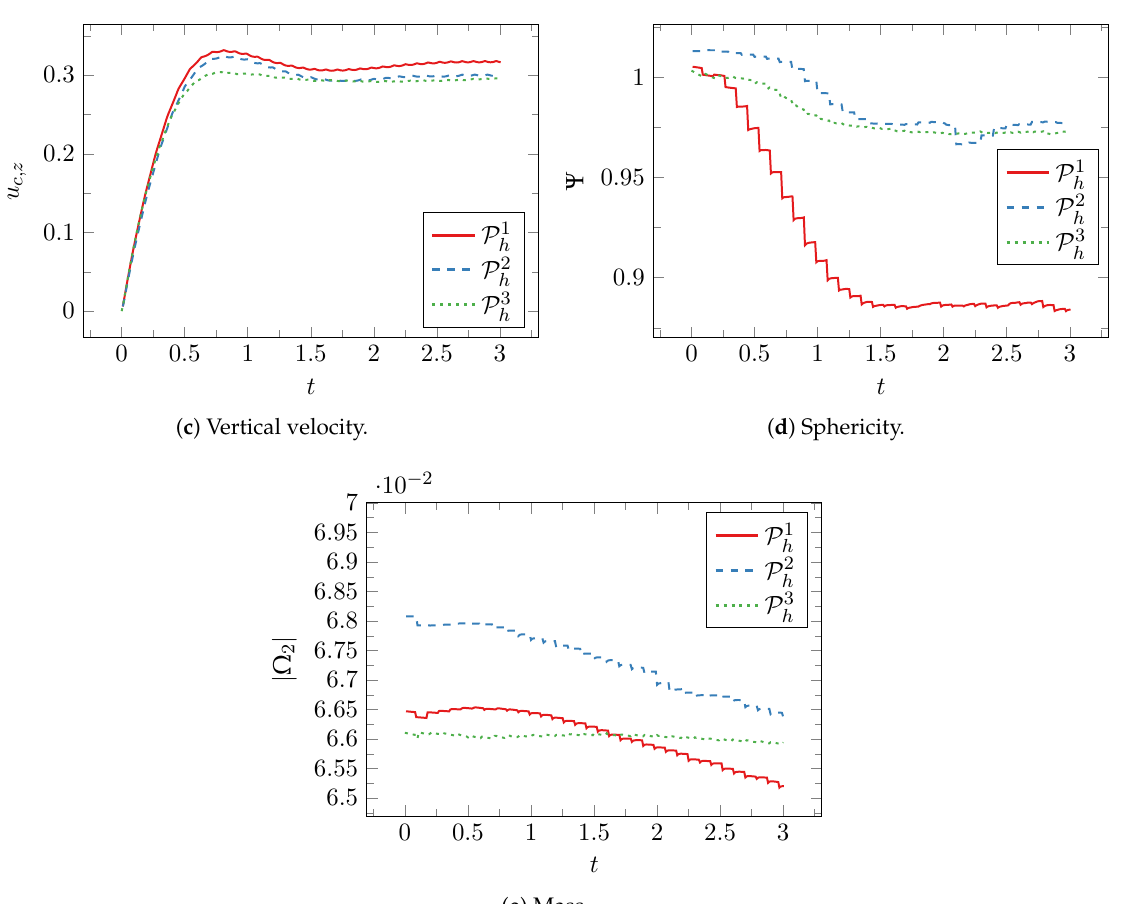
Figure 12. Comparison between P 1